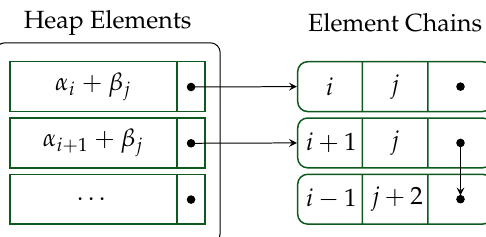
Figure 3. A heap of product terms, showing element chaining and index-based storing of coefficients. In this case, terms A i + 1 · B j and A i − 1 · B j + 2 have equal monomials and are chained